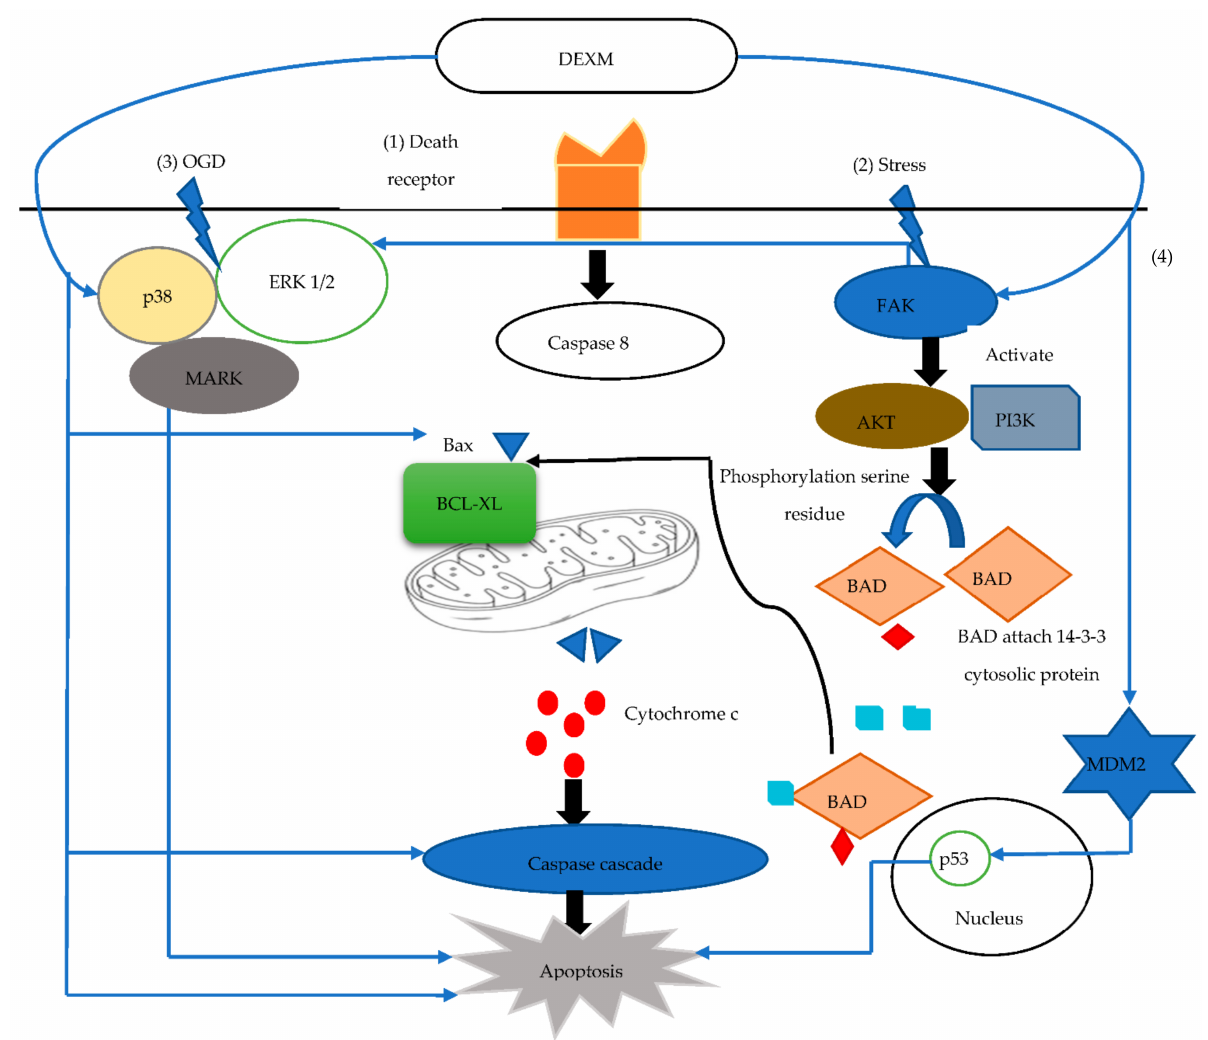
Figure 3. (1) Activation of death receptor release Caspase 8 that helps Ba bind with BCL-XL and releases cytochrome C (Cyt C) from mitochondria. Cyt C activates caspase cascade induced apoptosis. (2) Stress activates FAK, which activates AKT/PI3 K and ERK 1 . AKT helps BAD serine residue phosphorylation. Phosphorylated BAD attaches cytosolic 14-3-3 protein that 2 unbinds Ba with BCL-XL, attenuating apoptosis. (3) OGD induces necrosis by decreasing the p38 Mitogen-activated protein kinase (MAPK)/ERK1/2 pathways that attenuate apoptosis. (4) MDM2 reduces p53 activity, which induces